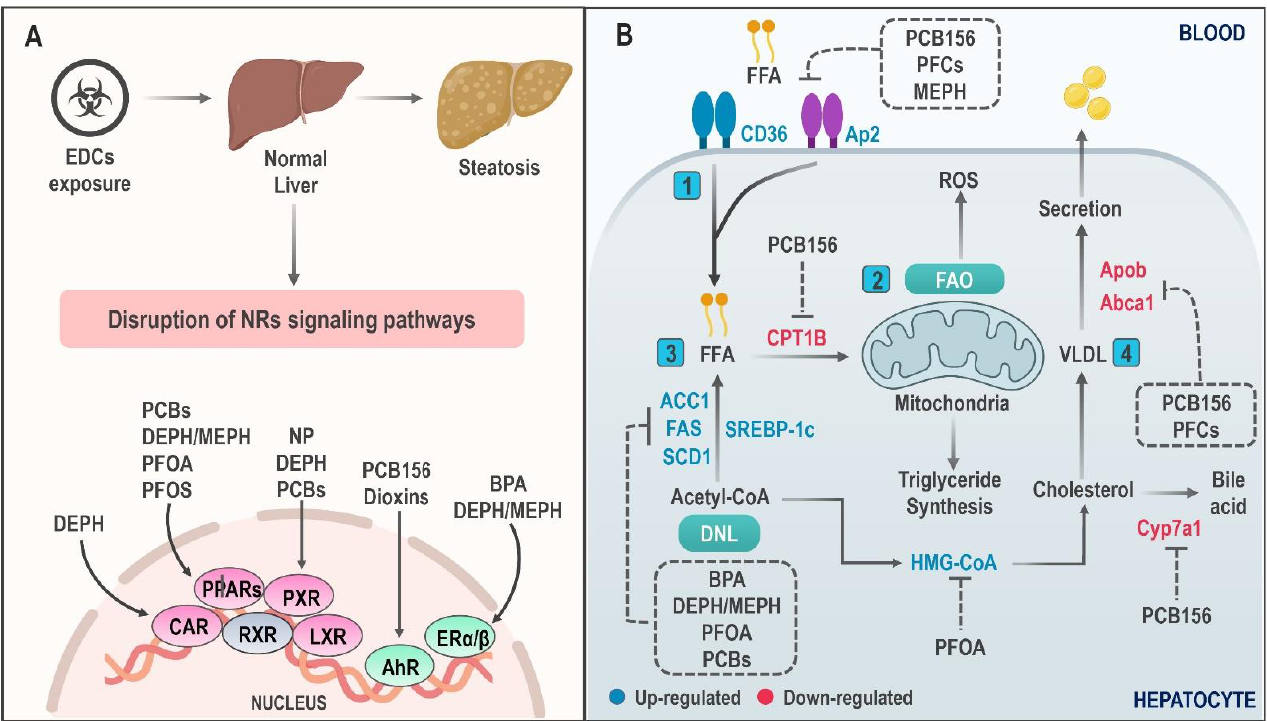
Figure 1. Molecular mechanisms involved in hepatic lipid accumulation induced by EDC exposure. ( A ) The steatosis- inducing effect of EDCs is mediated by binding with different nuclear receptors (NRs). The affinity profile of these substances for their receptors is variable. ( B ) NR signaling disruption with chemical exposure triggers an alteration in lipid metabolic pathways that promote lipids accumulation in the hepatocyte. Key mechanisms of action include (1) significantly increased lipid uptake, (2) decreased fatty acid oxidation, (3) increased expression of key regulators in de novo lipogenesis, and (4) blocking of lipid secretion in the form of VLDL particles and bile acid. Abbreviations: PCB: Polychlorinated Biphenyls; BPA: Bisphenol A; PFOS: Perfluorooctane sulfonate; PFOA: perfluorooctanoic acid; MEPH: Mono-(2-ethylhexyl) phthalate; DEPH: Di-(2-ethylhexyl) phthalate; NP: Nonylphenol; FAO: Fatty acid oxidation; FFA: Free fatty acid; ACC1: Acetyl-CoA carboxylase-1; SCD1: Stearoyl-CoA desaturase-1; FAS: Fatty acid synthase; VLDL: Very low-density lipoprotein; SREBP-1c: Sterol regulatory element-binding protein-1c; CD36: cluster of differentiation 36; DNL: De novo lipogenesis; ROS: reactive oxygen species.